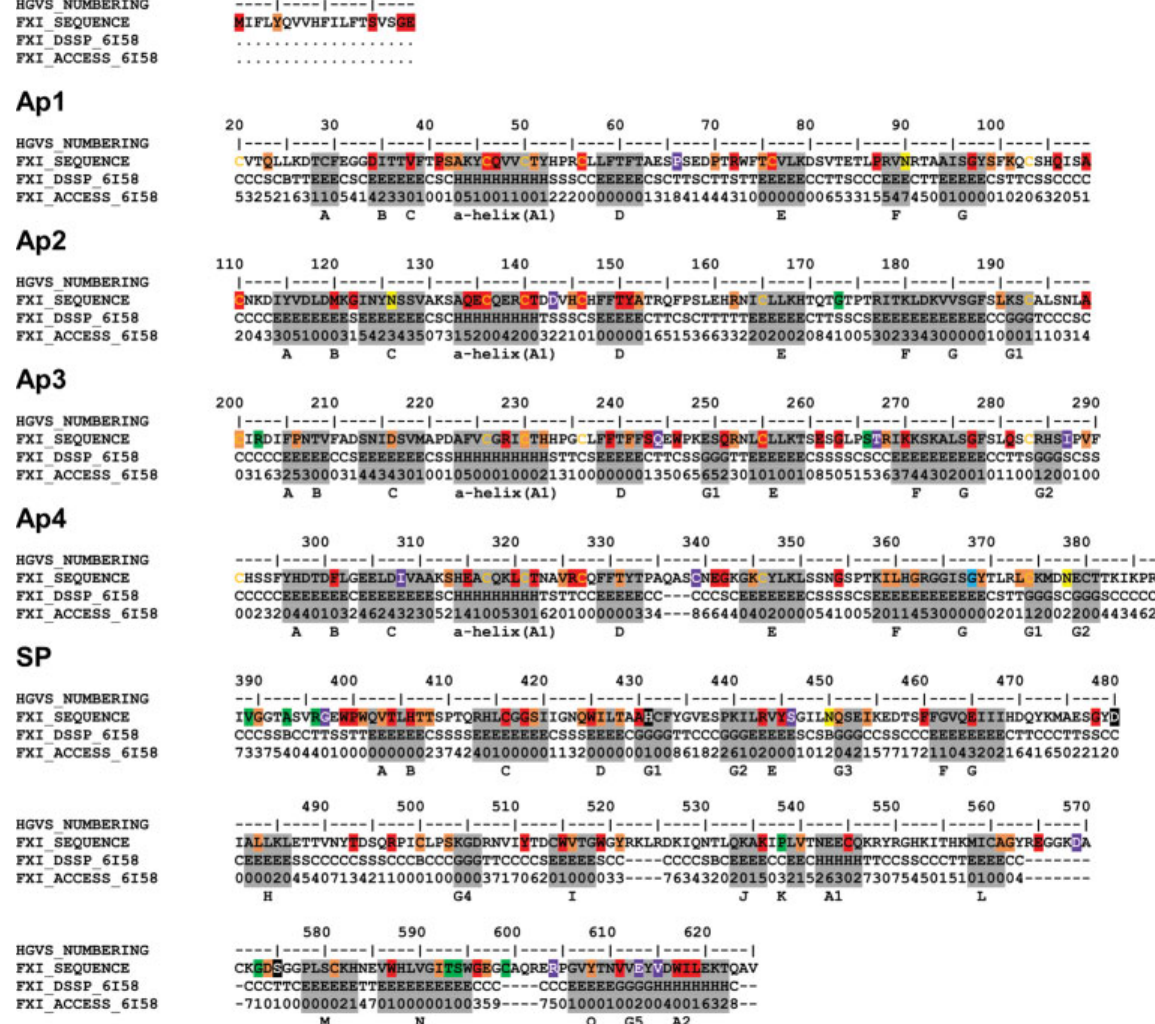
Fig. 3 Secondary structure and accessibility analysis of variants in the FXI crystal structure. The FXI sequence is shown with the secondary structure assignments highlighted in gray boxes. Residues are denoted either H ( α -helix), B ( β -bridge), E (extended β -strand), G (3 10 helix), I ( π - helix), T (hydrogen-bonded turn), S (bend) or C (unde fi ned coil region). β -strands are labeled alphabetically in the order in which they occur. The β -strands in the Ap and SP domains are denoted A-G and A-O respectively. 3 α (cid:3) helices are denoted A1-A2. The 10 -helices are denoted G1-G5 and SP catalytic triad His431-Asp480-Ser575 residues (legacy numberingHis413-Asp462-Ser557) are highlighted in black. The 24 conserved cysteine residues within the four Ap domains are shown in yellow text. Putative N-glycosylated residues are highlighted in yellow boxes. The positions of 198 point variants found in the F11 gene are highlighted, where 75 red highlights denote Type I mutations, 11 green highlights denote Type II mutations, and 56 orange highlights denote mutations with unknown phenotype. The 13 purple highlights denote non-disease associated polymorphisms and the blue highlight denotes a Gly368 residue (legacy numbering Gly350) associated with both Type I and Type II